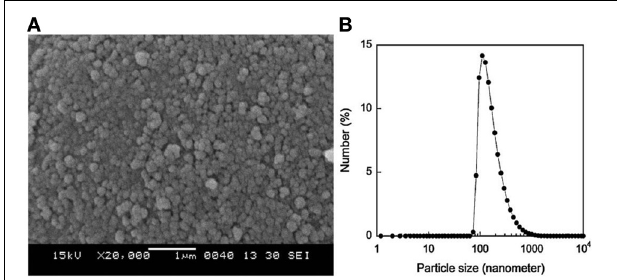
FIGURE 11 | Particle size distribution of UFPR (A), PLA-UFPR1 (B), and PLA-UFPR5 (C). D n , average particle diameter; sn, average matrix ligament thickness (interparticle distance). [Reprinted from Zhao et al. (2013) with permission from Elseiver].